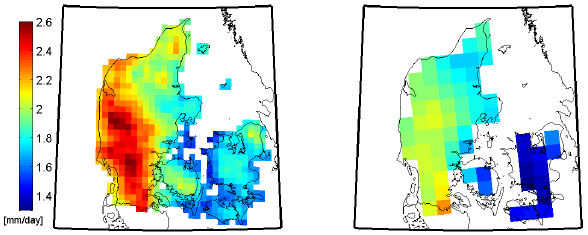
Fig. 2. The mean precipitation (Mean) of Denmark for CGD (left) and E-OBS (right).